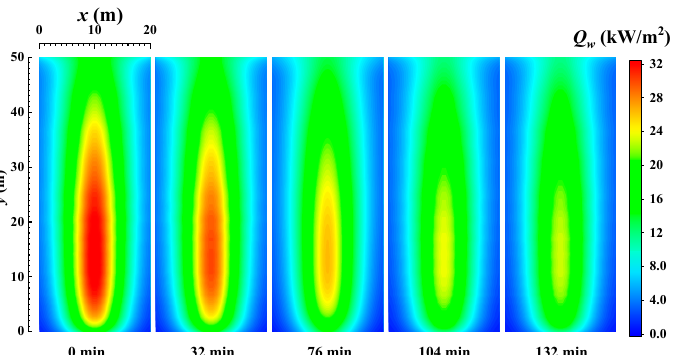
Figure 3. The distribution of the local heat flux density of the wall when burning bituminous coal (Illinois #6).